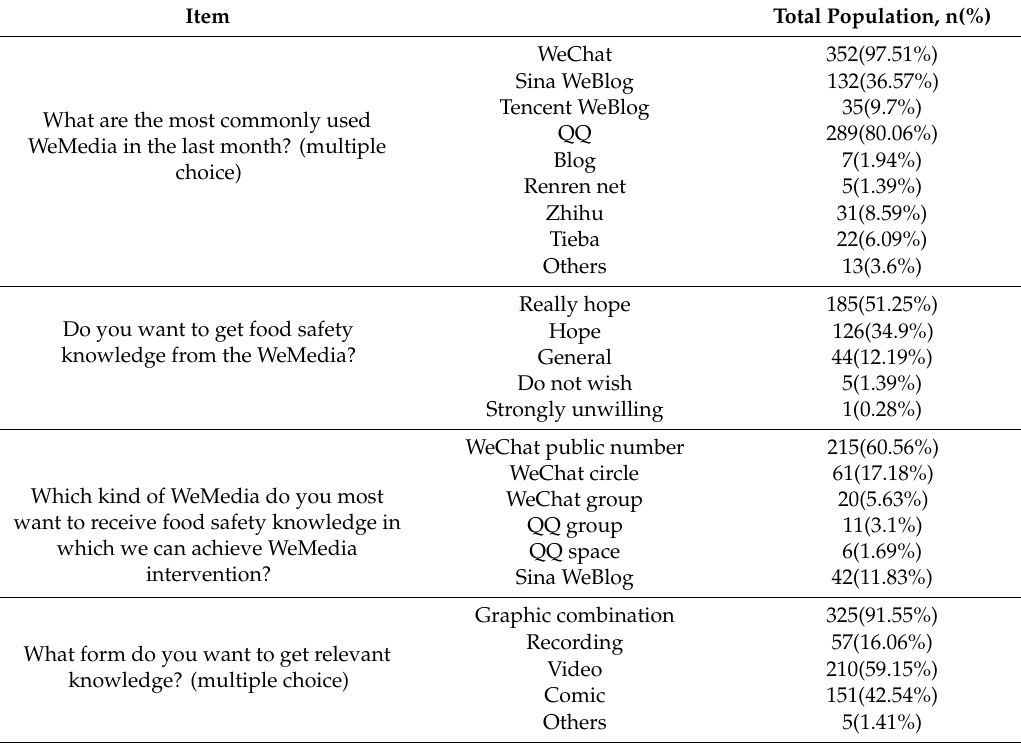
Table 5. Status of WeMedia use and demand for science popularization (n =